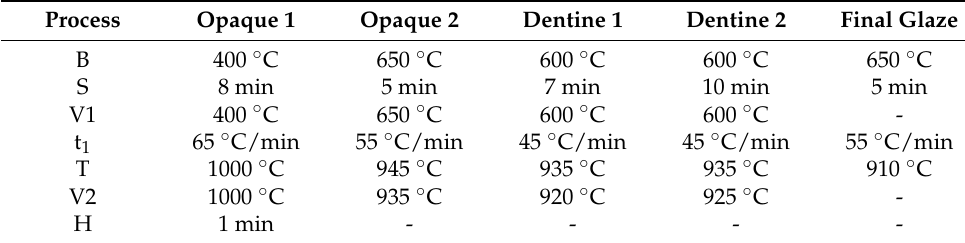
Table 2. Processes of the applied heat treatment (HT).